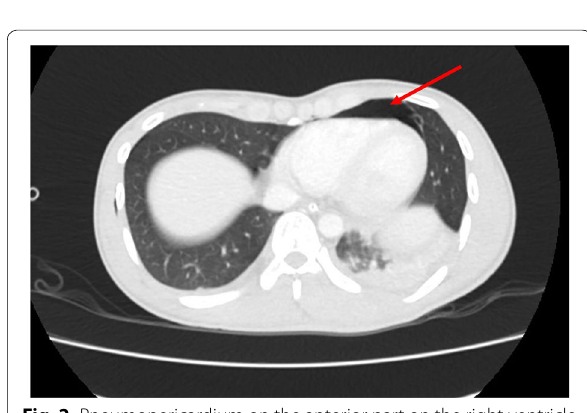
Fig. 2 Pneumopericardium on the anterior part on the right ventricle (red